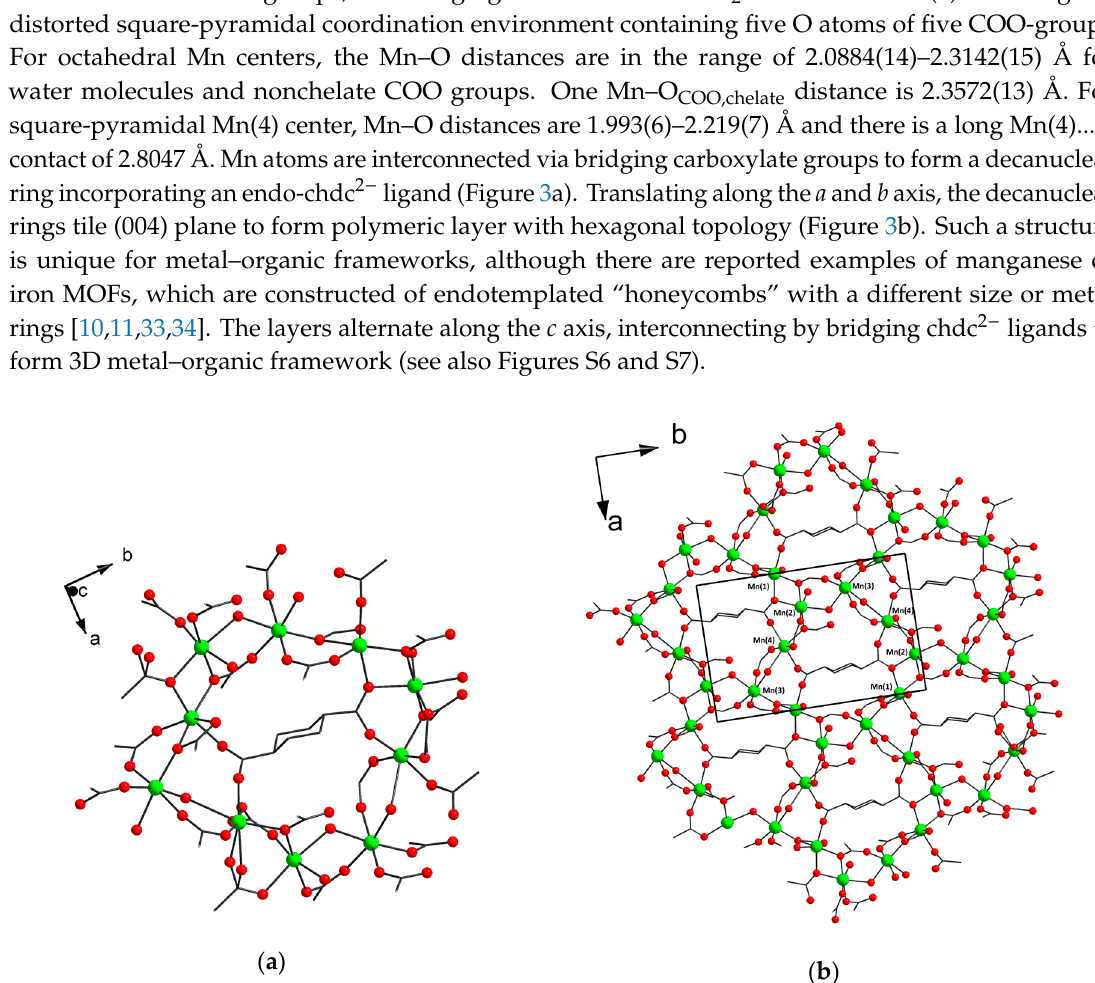
Figure 2. Fragment of polymeric chain ( a ) and 3D metal–organic framework ( b ) in 3 (CCDC 1973664). Hydrogen atoms and guest CH 3 CN molecules are omitted for clarity.